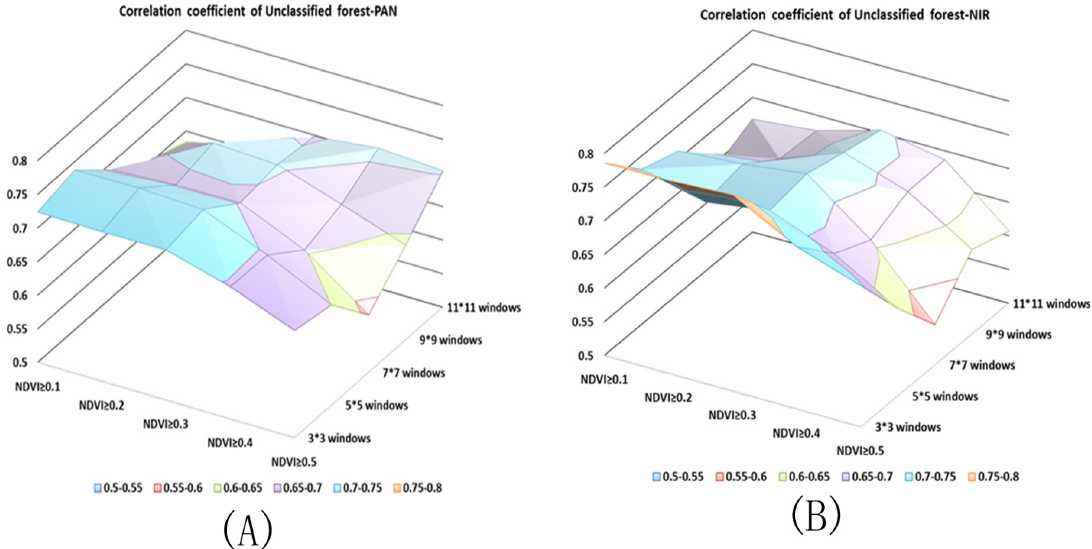
Fig 3. Correlation Coefficients of unclassified stand between stand density based on different window sizes and NDVI threshold and true stand density. (A) Correlation coefficient of the PAN. (B) Correlation coefficient of the NIR.